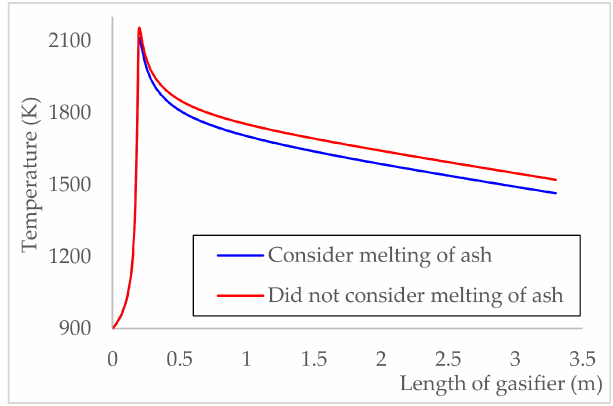
Figure 6. Differences in temperature profile depending on whether melting of ash is considered or